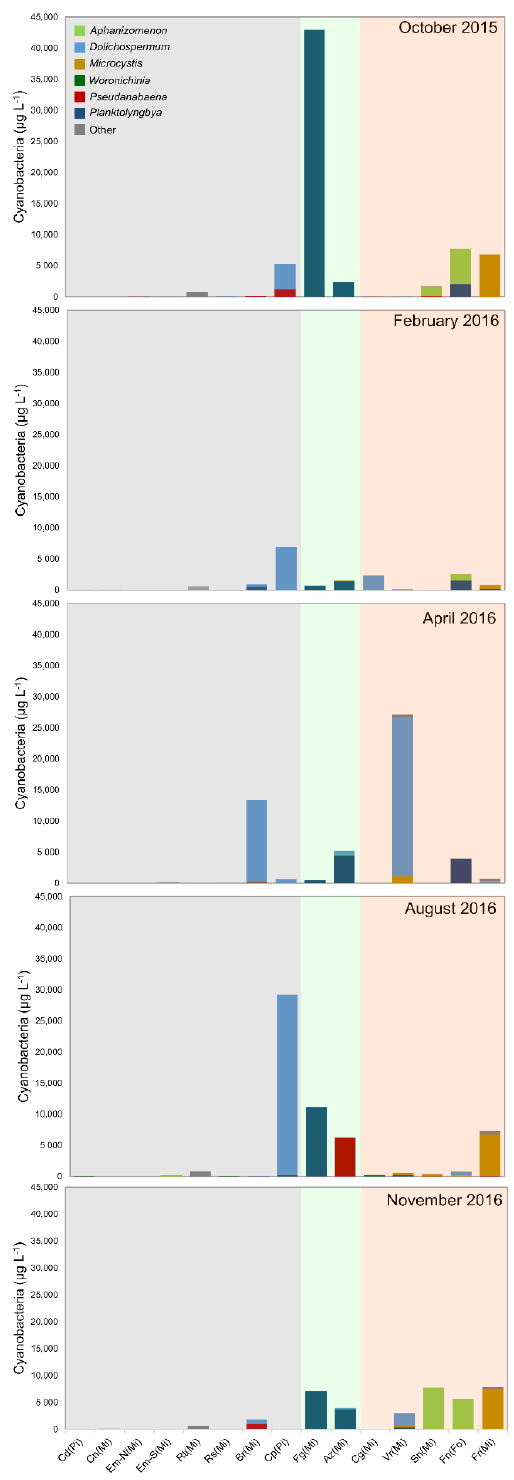
1 Figure 2. Cyanobacteria biomass ( µ g L − 1 ) in the photic zone of the 15 sampled lakes, by sampling campaign. Aphanizomenon : A. gracile ; Dolichospermum : Dolichospermum sp., D. planctonicum , and D. spiroides ; Planktolyngbya : Pl. limnetica ; Woronichinia : W. naegeliana ; Pseudanabaena : Ps. limnetica ; Microcystis : M. aeruginosa and M. flos-aquae ; Other: Coelosphaerium kuetzingianum ; Chroococcus minutus ; C. turgidus ; Oscillatoria tenuis ; Snowella lacustris and Synechocystis sp. Grey shadow: Shallow Lakes; Green shadow: Deep Mesotrophic lakes; Orange shadow: Deep Eutrophic